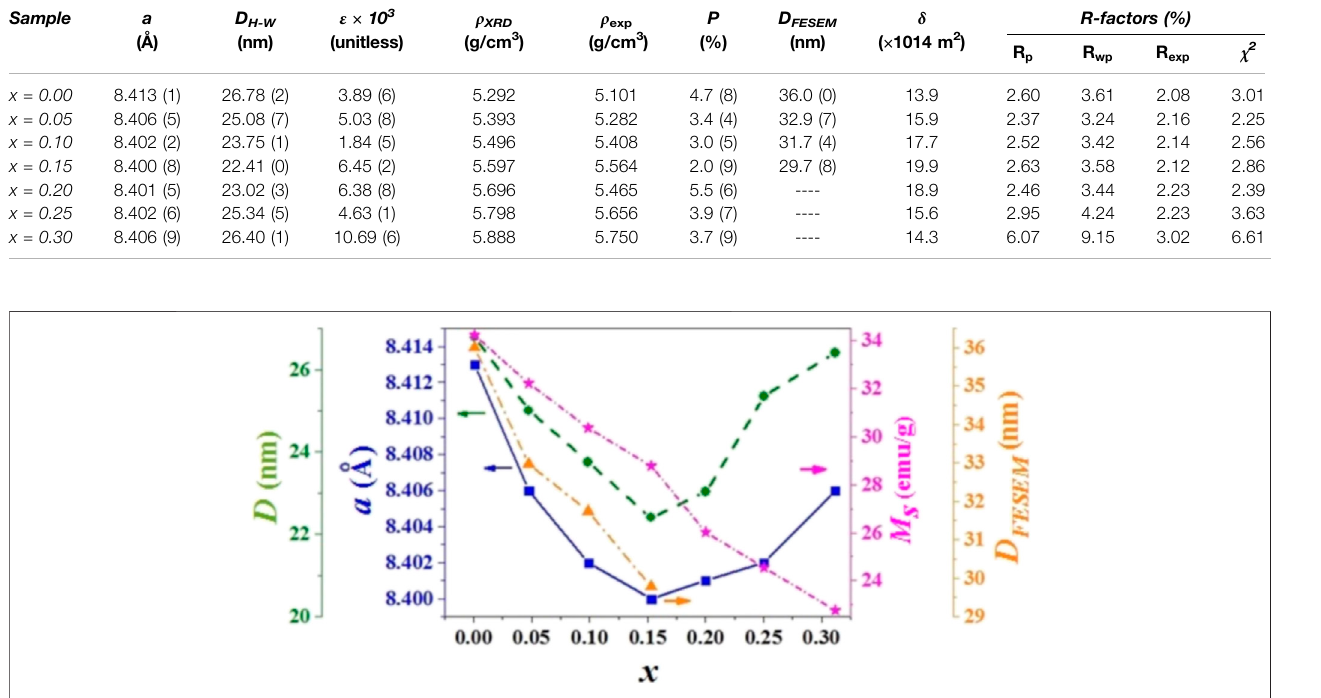
FIGURE 2 | Changes of the a , D , M s , and D FE-SEM of Cd x Mg 0.30- x Cu 0.20 Zn 0.50 Fe 2 O 4